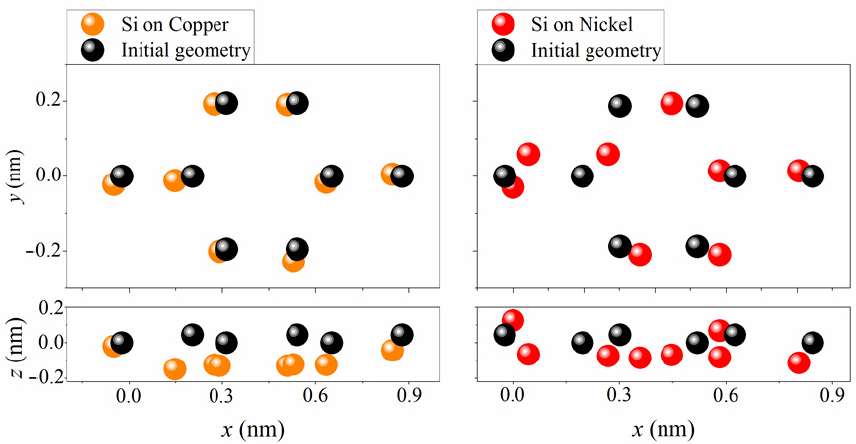
Figure 4. Geometric structures of silicene on four-layer copper and nickel substrates obtained by the time instant of 2000 ps in ab initio MD calculation at a temperature of 500 K (orange and red circles) and initial silicene structures (black circles).